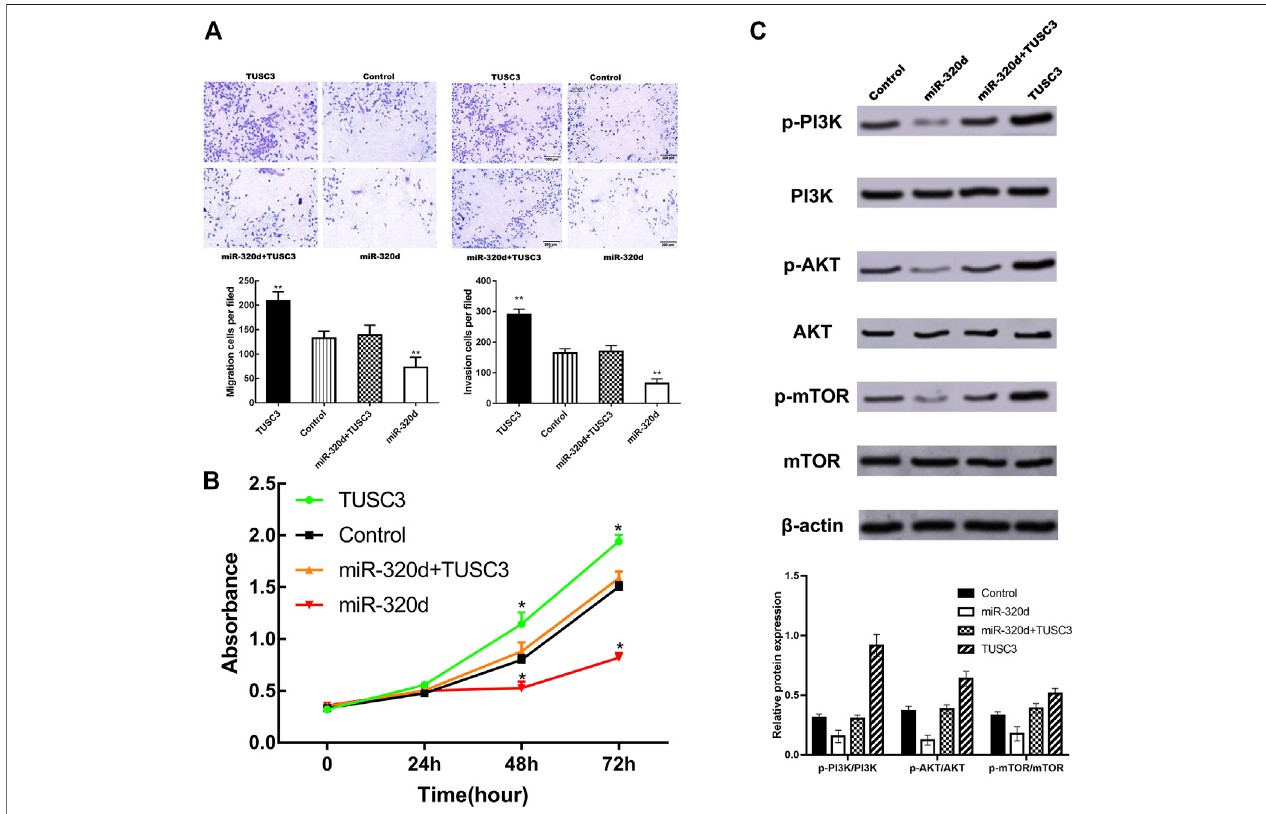
FIGURE5 | miR-320d inhibits the EGFR-positive CRC cell migration, invasion, and proliferation and negatively regulated PI3K/AKT/mTOR signaling pathway cells by downregulation of TUSC3. (A) Transwell assays and (B) MTT assays were conducted in EGFR-positive CRC cells transfected with miR-320d or miR-320d and TUSC3 or Control or TUSC3. (C) The expression of these proteins was detected by Western blot after the restoration of TUSC3. Assays were performed in triplicates. Mean ± SD is shown. Statistical analysis was conducted using one-way ANOVA. ** p < 0.01; * p < 0.05, compared to miR-320d and TUSC3 groups.; Abbreviations